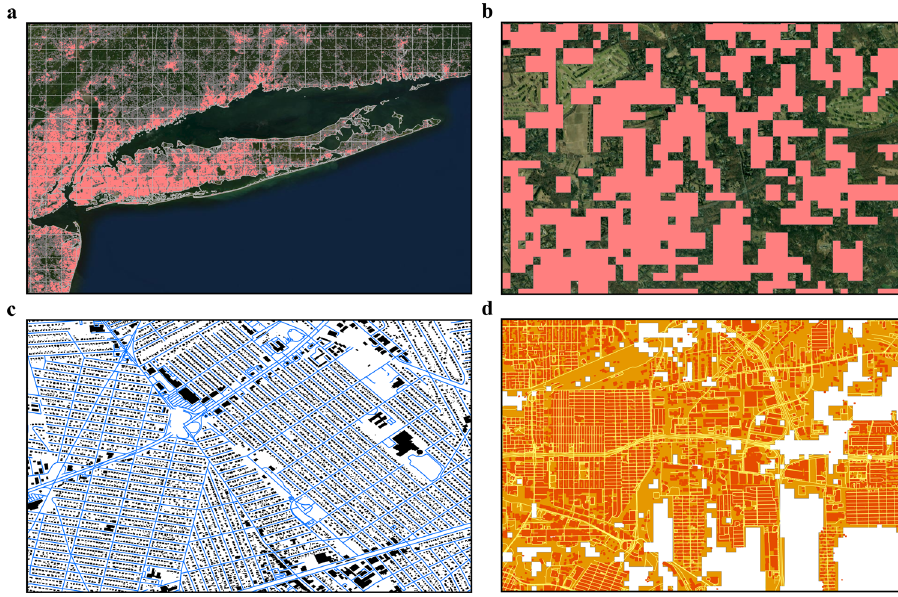
Fig. 2 Visual representation of a sample FN involved in Bottom-up methods. a The image is depicting an area over New York, USA. The gridlines are the geographical boundaries of Fishnet cells (FN), with each cell size of 10 km 2 . The red area inside each FN is the built area (BA FN ). b The green areas in the image are the non-built-up geography in the year 2015, with red areas representing BA FN as 100 m 2 blocks. Each block has a value of 0 – 100% based on the percent of built-up area in a block. c The black polygons are the building footprints (BF FN ) derived from big data sources, inside a sample FN. The blue lines are the roads (RL FN ) inside the sample FN, with white areas representing empty spaces that are not used in our analysis. d The image represents the four main categories of objects present inside each sample FN. The orange areas are the BA FN blocks, with red areas representing the actual buildings, yellow lines representing roads, and white areas are the areas not considered in our study. Data Credits: Copernicus GLC Landcover, Microsoft Building Footprints, and Open Street